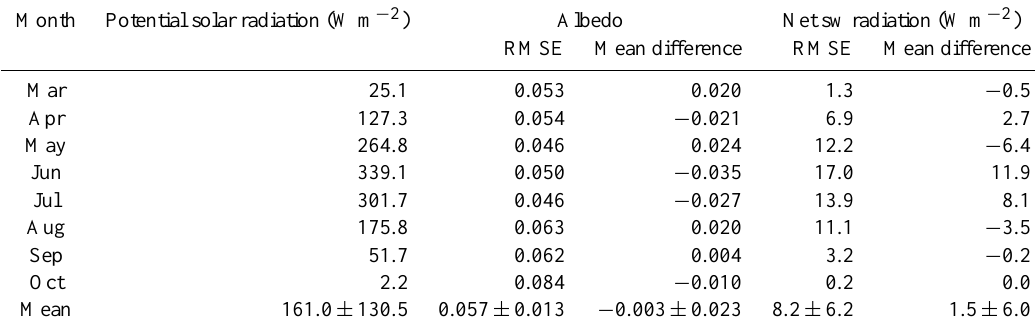
Table 3. Mean monthly deviations between MODIS-observed albedo and albedo modelled using the FAM and the resulting deviations in net shortwave radiation flux at the glacier surface. Deviations are expressed as both root mean square error (RMSE) and mean difference. The monthly mean potential solar radiation fluxes are calculated using standard solar geometry algorithms (M¨oller et al., 2011a) and refer to a latitude of 80 ◦ N. The mean values are given with a ± one standard deviation